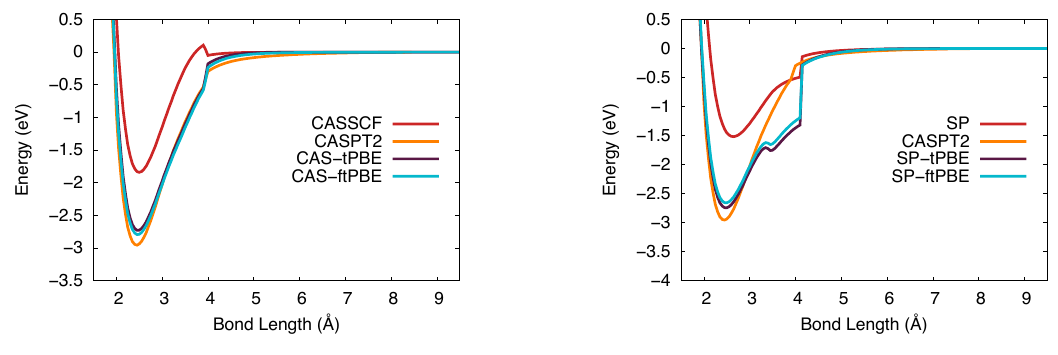
Figure 7. The potential energy curve for niobium silicide in the 6 Σ + ground state. ( Left ): Computed with CASSCF (red), CASPT2 (orange), CAS-tPBE (purple), CAS-ftPBE (blue) with a (7,10) active space. ( Right ): Computed with SP (red), SP-tPBE (purple), SP-ftPBE (blue) with a GAS5(7,10) active space. CASPT2 (orange) is included for comparison.